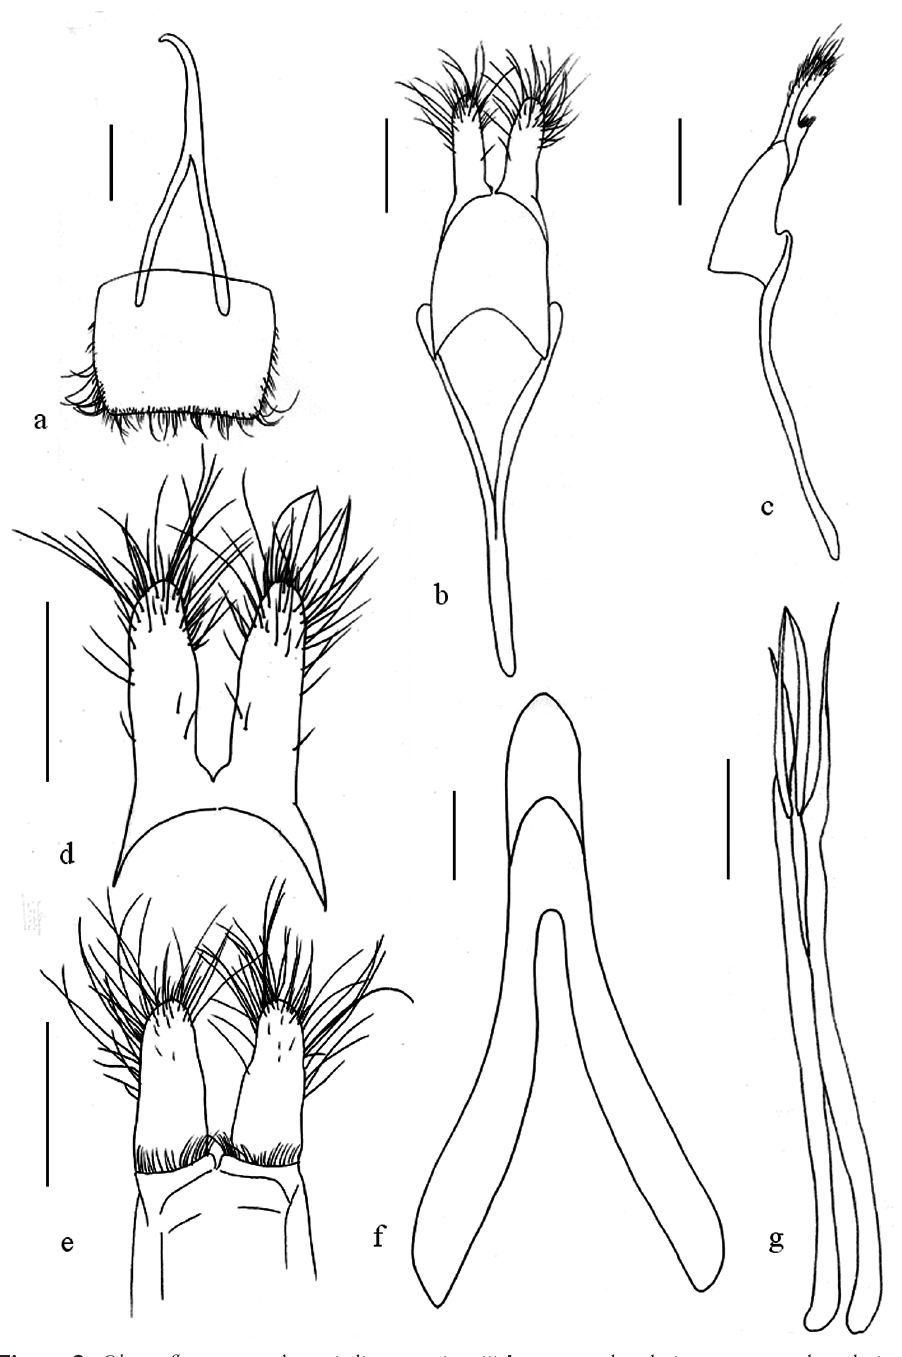
Figure 2. Oberea flavescens , male genitalia, a tergite viii b tegmen, dorsal view c tegmen, lateral view d parameres, dorsal view e parameres, ventral view f median lobe, ventral view g sclerities in endophallus. Scale bar 0.5